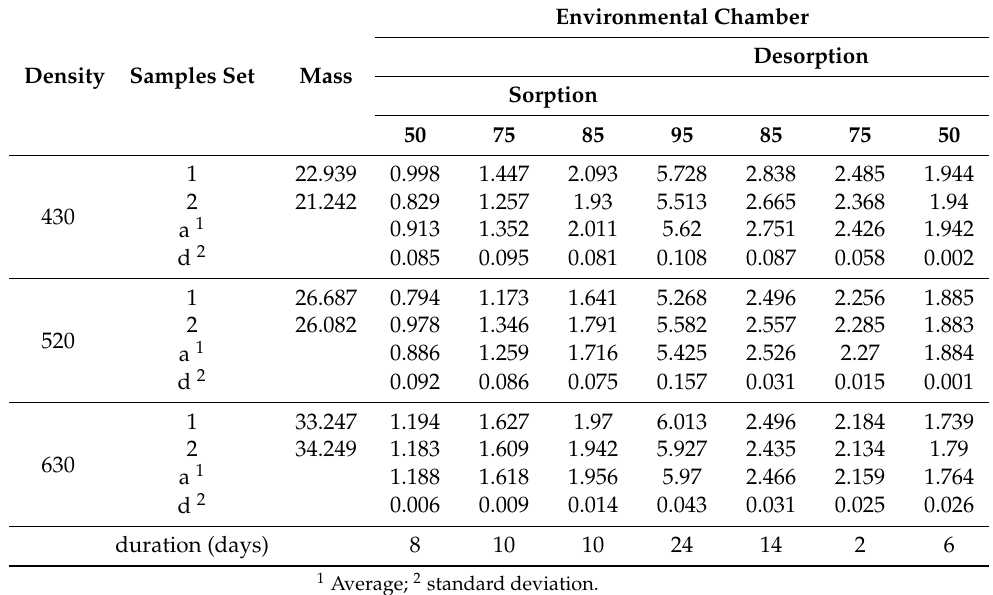
Table 8. Results of environmental chamber tests.